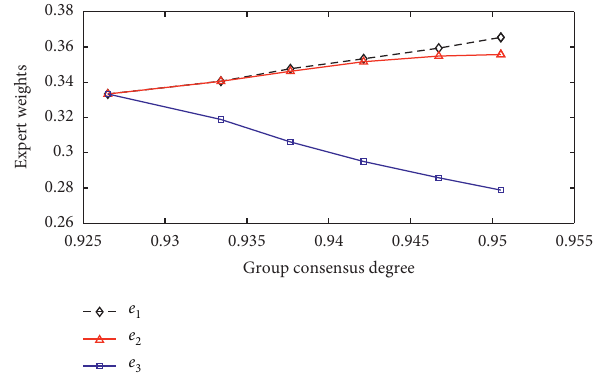
Figure 5: Group-consensus levels with the updating of weights of experts by Algorithm